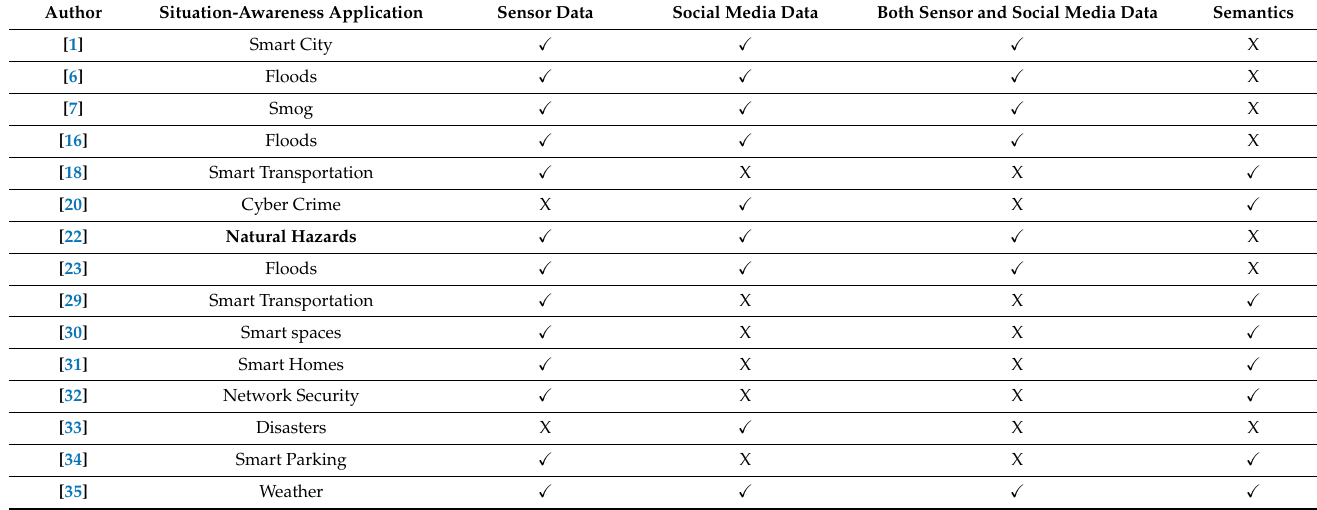
Table 1. Situation Awareness Applications, their data sources, and use of